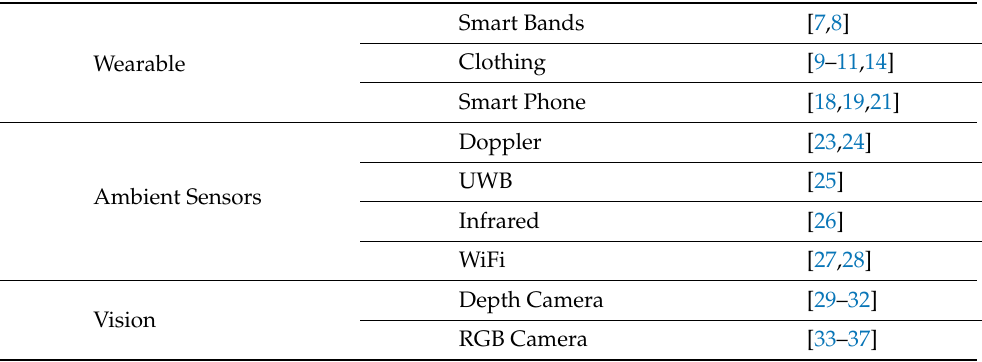
Table 1. Summary of data collection methods for fall